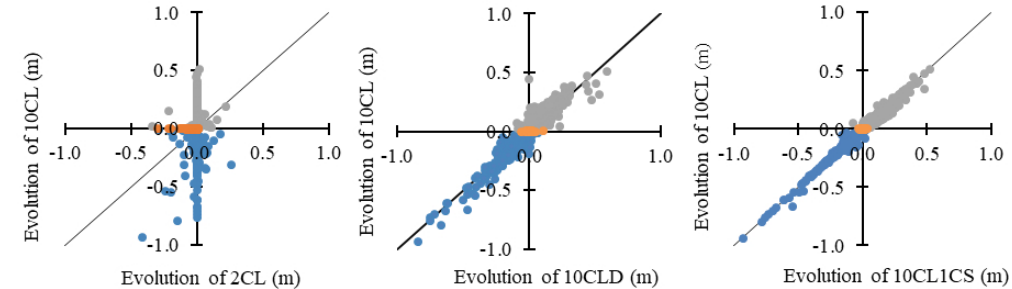
Figure 8. Cross-comparison of bed elevation evolutions (elevation final–initial) simulated for the 2CL, 10CL1CS, and 10CLD configurations using the model configuration 10CL as a reference. The colours correspond to the 10CL’s bathymetry evolution: grey is the deposition, orange is the stable bathymetry, and blue is the erosion.